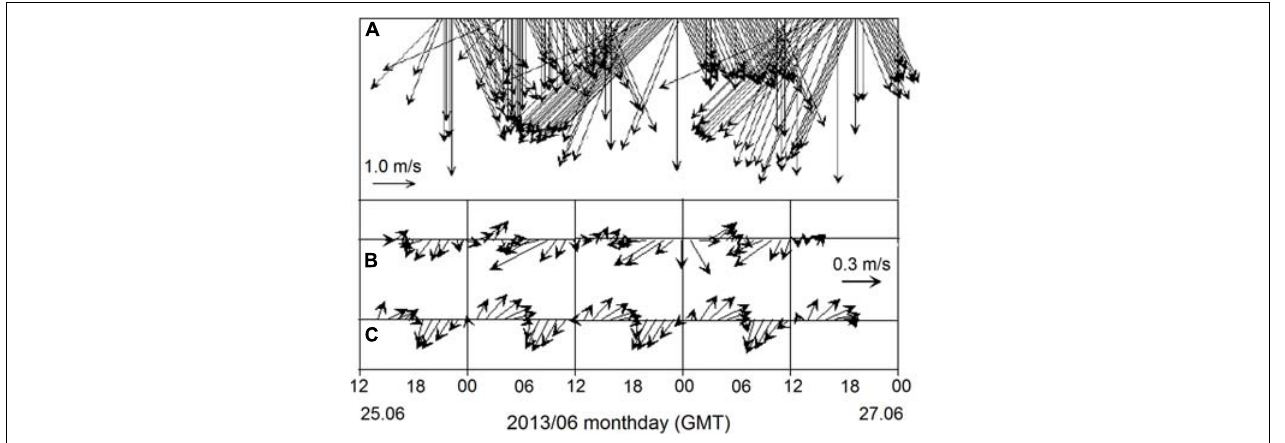
FIGURE 13 | Series of (A) wind speed, (B) hourly averaged vectors of current velocity at the depth 9 m obtained at the mooring station (“ SeaHorse” ), and (C) the current velocity modeled with the POM at site F (modified from Korotenko et al.,